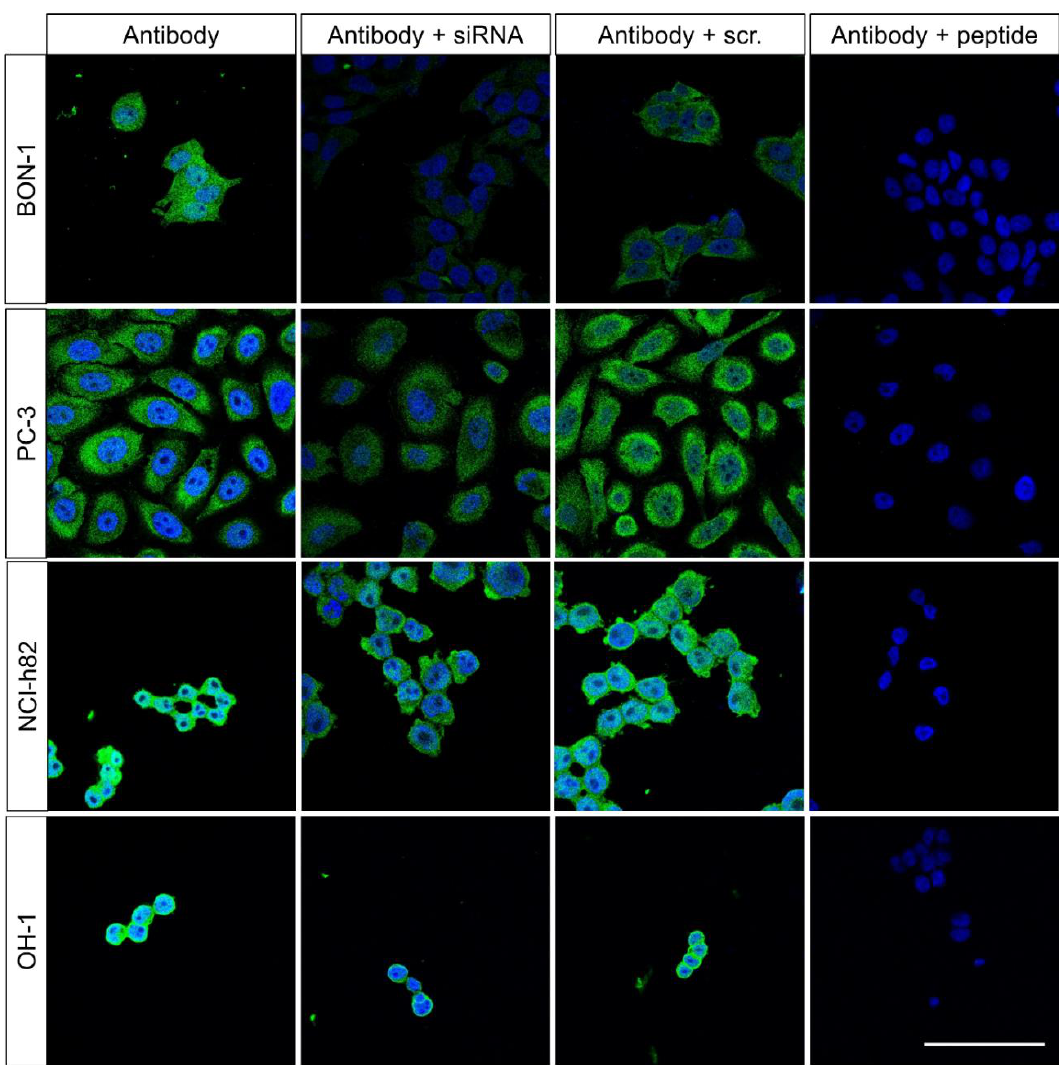
Figure 1. Immunocytochemical analysis of FAM159B expression in BON-1, PC-3, NCI-h82 and OH-1 cells. Left three panels: cells remained untreated or were transfected with specific siRNA or a scrambled siRNA (scr.) and then fixed and stained with anti-FAM159B HPA011778, followed by Alexa Fluor 488-conjugated anti-rabbit secondary antibody. Right panel: For adsorption controls, anti-FAM159B HPA011778 was pre-incubated for 2 h prior to immunocytochemistry with 10 µg/mL of the peptide used to immunise rabbits. Green: immunosignal; blue: DAPI staining of DNA. All photomicrographs were taken at the same magnification. Scale bar: 100 µm.